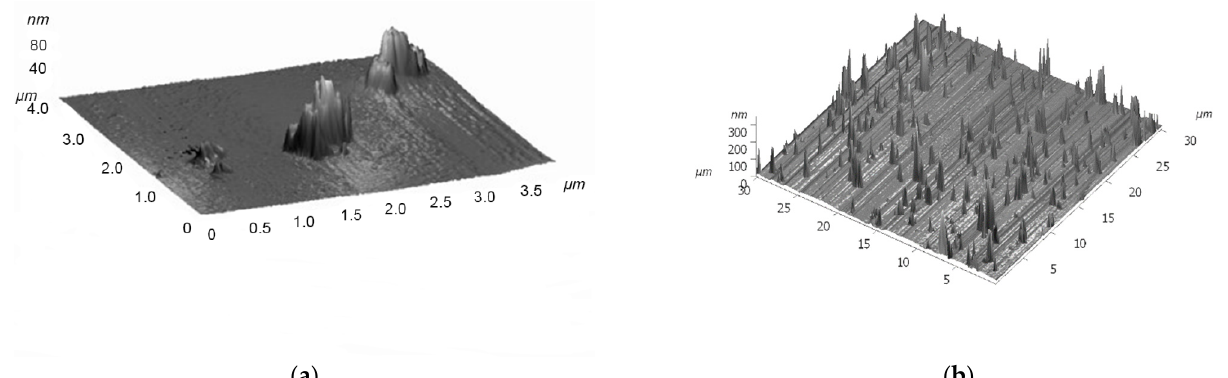
Figure 2. ( a ) AFM 3D image of structures (5.0 × 5.0 (µm)) with h ∼ 80–100 nm, formed on a modified silicon surface, based on triple complexes Ni(acac) 2 ∙ NMP ∙ PhOH (3.5 μ m × 3.5 μ m); ( b ) AFM 3D image of structures (30 × 30 (µm)) with h ∼ 300 nm, based on triple complexes Ni(acac) 2 ∙ NaSt ∙ PhOH.